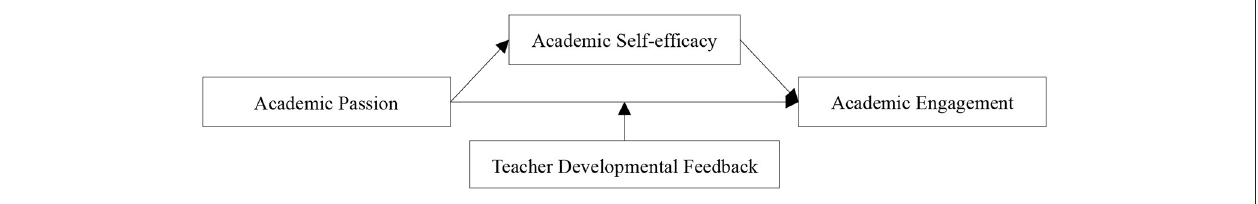
FIGURE 1 | Research